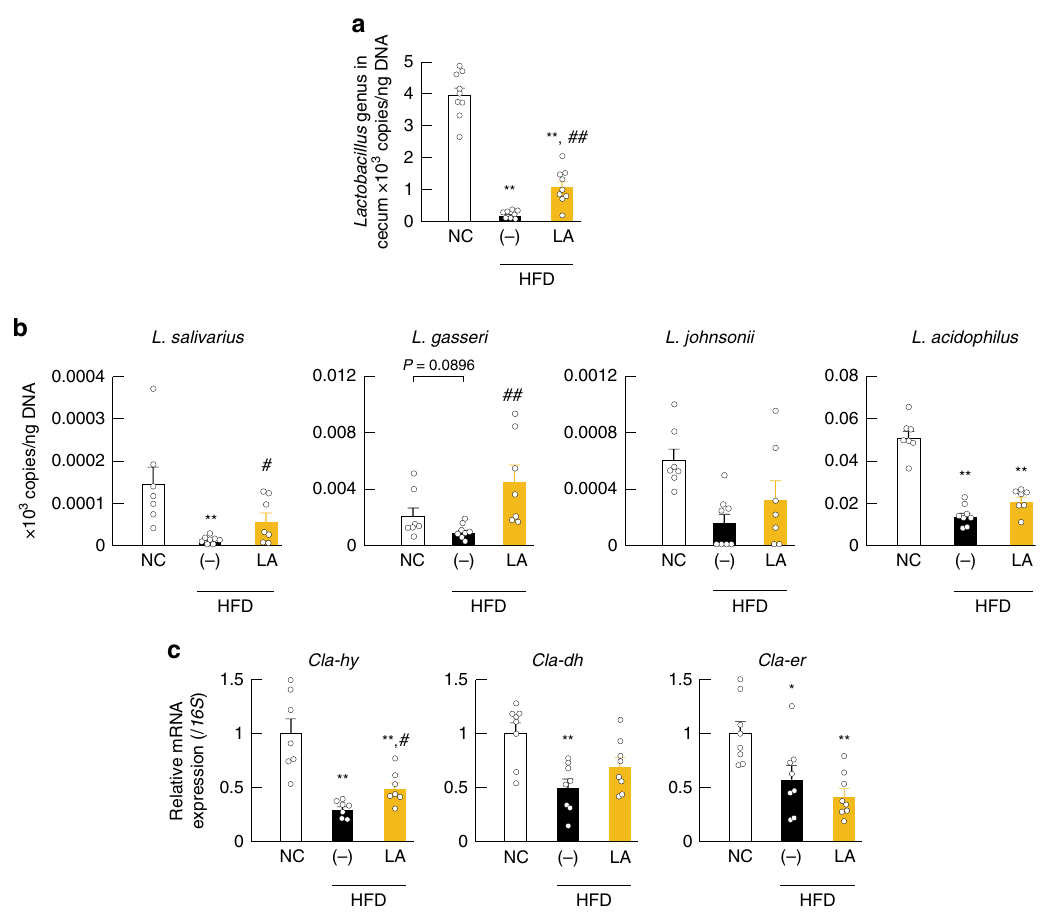
Fig. 2 HYA-producing lactic acid bacteria. a The abundance of Lactobacillus was analyzed by qPCR ( n = 9, 8, and 9 per group). b The abundance of the Lactobacillus strains ( n = 7, 8, and 7 per group) and c the relative mRNA expression of metabolite-synthesizing enzymes ( Cla-hy , Cla-dh , and Cla-er ; see Supplementary Fig. 1) ( n = 7 per group for Cla-hy ; n = 8 per group for Cla-dh and Cla-er ) in cecum were analyzed by qPCR and qRT-PCR. ** P < 0.01, * P < 0.05 vs. NC (Tukey – Kramer test). ## P < 0.01; # P < 0.05 vs. ( − ) (Tukey – Kramer test). ( − )_HFD represents high-fat diet-fed mice. Results are presented as means ± SE. Source data are provided as a Source Data fi le